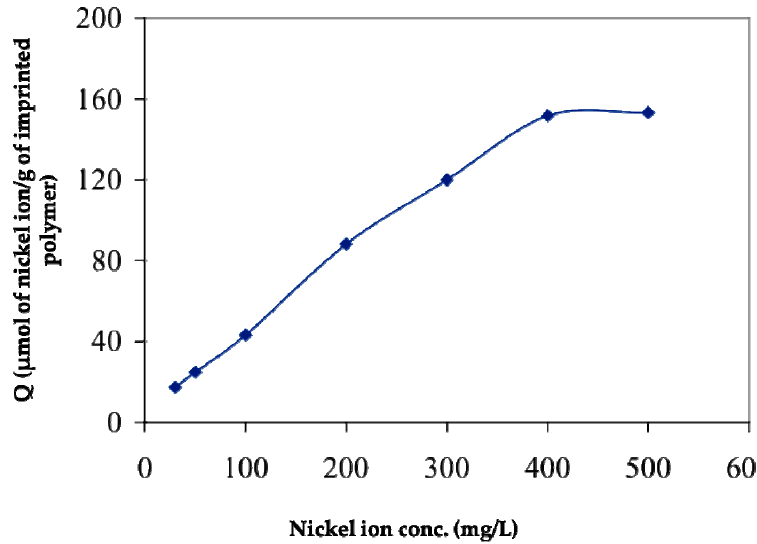
Figure 7. Effect of nickel (II) concentration on the amount of adsorbed nickel (II). Republished with